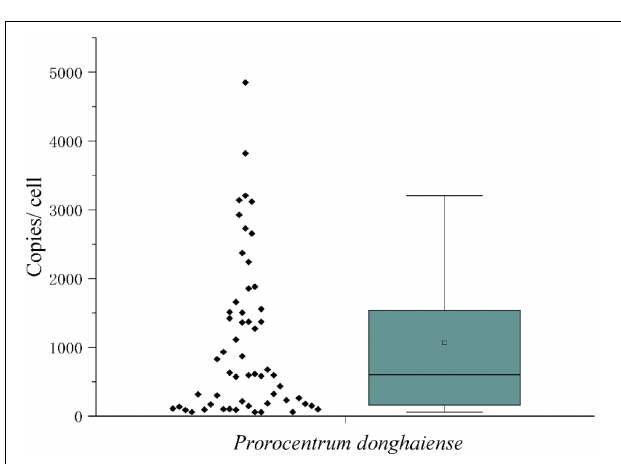
cultures together with the cyst from sediment maintaining intactness under a long storage at 4 ◦ C justify that the cysts are “resting cysts” rather than “temporary cysts.” The P. donghaiense resting cyst was subspherical to spherical, had a smooth surface, golden brown accumulation body, and thick wall, which